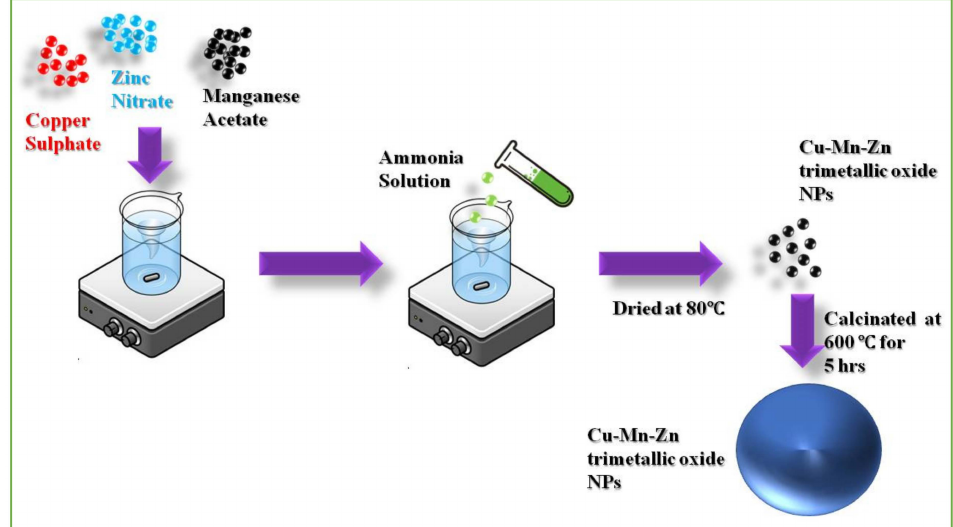
Figure 1. Synthesis of Cu-Zn-Mn mixed trimetal oxide nanoparticles